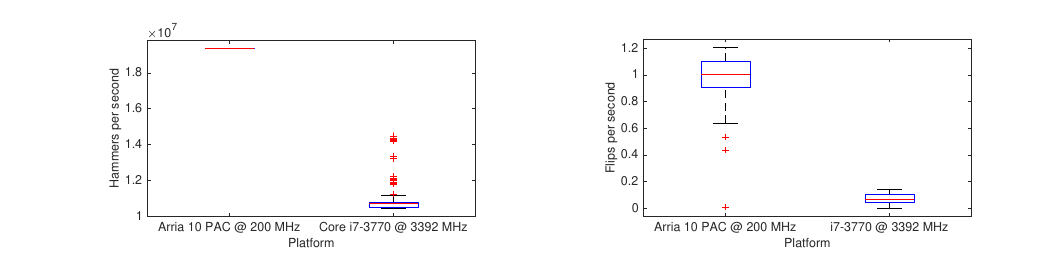
Figure 2: Distributions of hammering rates (memory requests per second) on FPGA PAC and i7-3770.